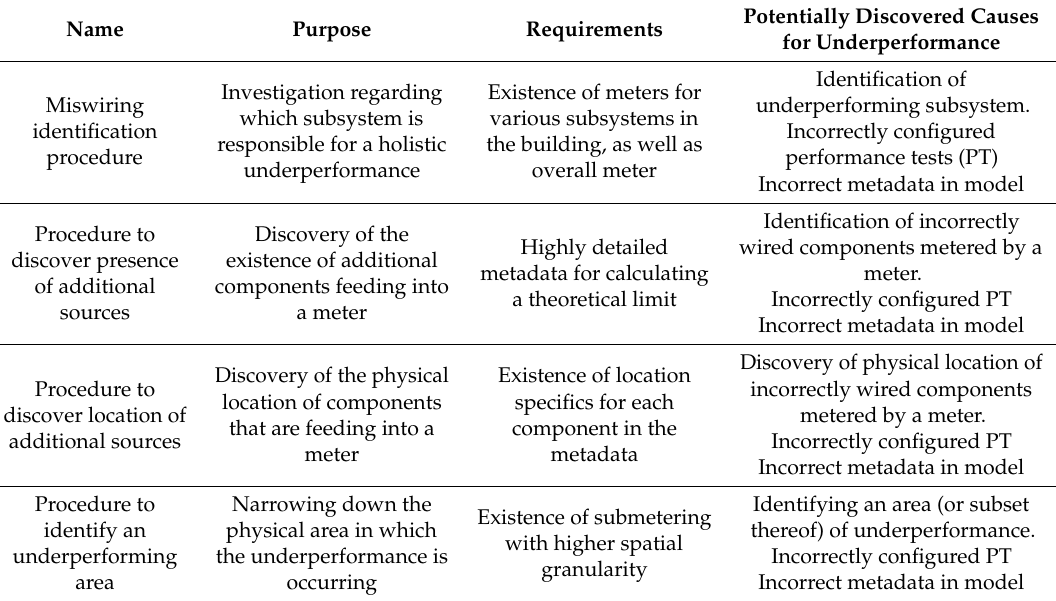
Table 1. Procedures for evaluation of